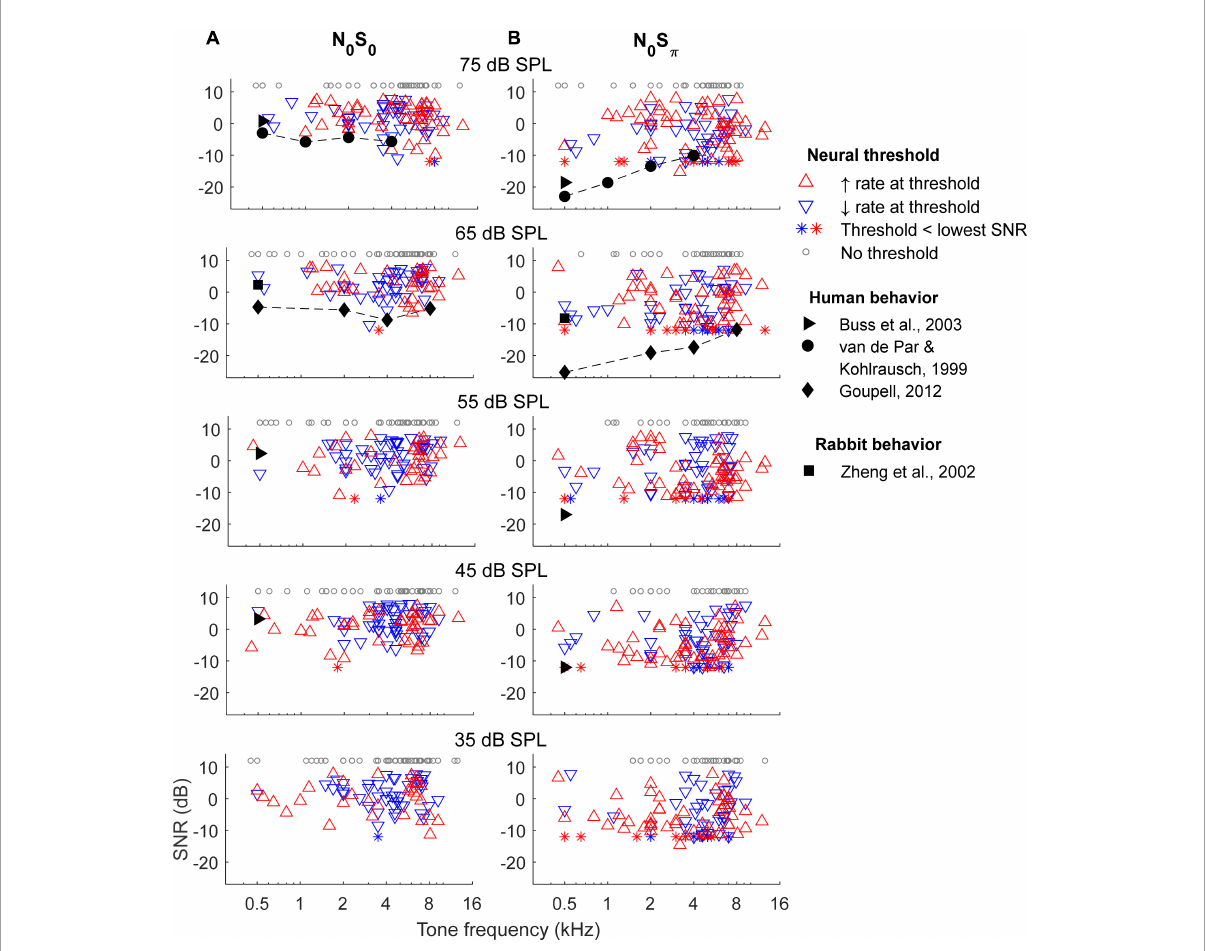
FIGURE7 Rate-based threshold for N 0 S 0 (A) and N 0 S π (B) conditions. Thresholds of most sensitive neurons across frequencies matched human behavioral data for the N 0 S 0 condition, but had a trend different from human for the N 0 S π condition. Neural thresholds at 500 Hz matched rabbit behavioral data for both